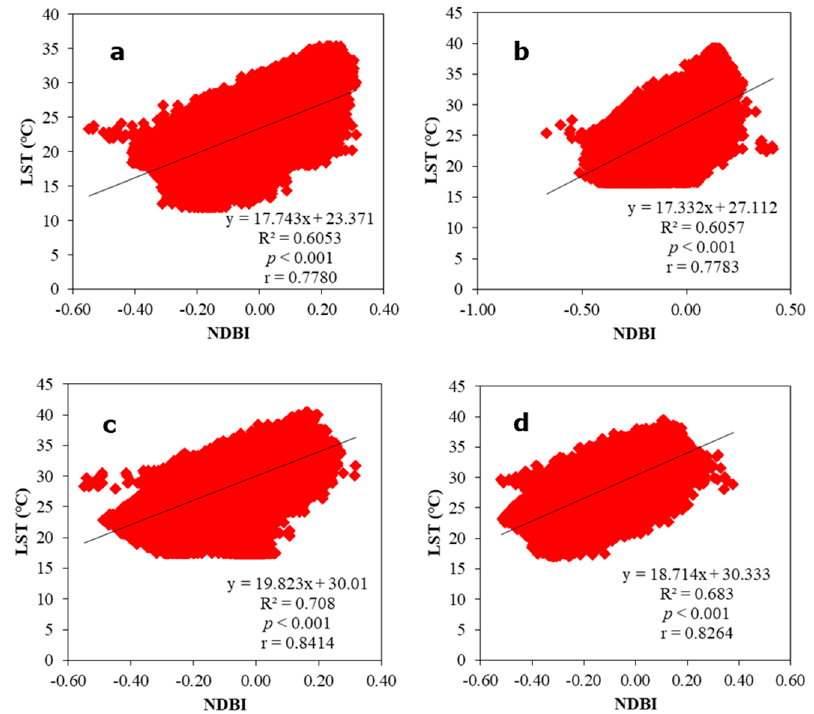
Figure A3. Scatter Plots between LST and NDBI for ( a ) 1988; ( b ) 1998; ( c ) 2008; ( d ) 2018.